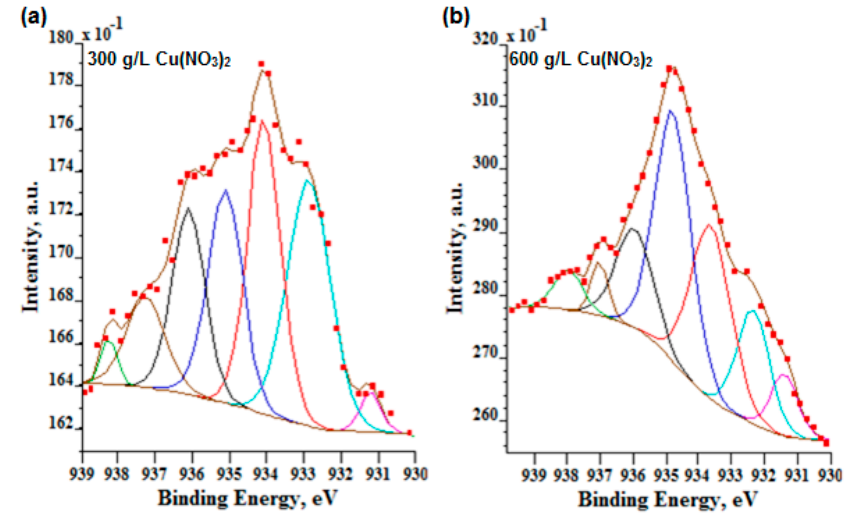
Figure 8. High XPS resolution Cu 2p 3/2 spectra within their fitting of the surface layer formed on titanium after PEO in the electrolyte containing 300 g/L ( a ) and 600 g/L ( b ) of Cu(NO 3 ) 2 in H 3 PO 4 . In Figure 8 and Table 5, the high resolution Cu 2p 3/2 spectra for two high signals (300 g and 600 g of Cu(NO 3 ) 2 per 1000 mL H 3 PO 4 ) are presented. The two first peaks at 932.3 eV and 932.9 eV (Figure 8a) and 932.4 eV (Figure 8b) and for both analyzed electrolytes can be interpreted most likely as CuP 2 and Cu 2 O, respectively. Other peaks of the ingrown energies are also responsible for the presence of Cu 2+ , i.e. , 933.6, 934.1 eV are responsible mostly for CuO; 934.8, 935.1, 936.1, 937.2, 938.1 eV peaks may be responsible for the presence of Cu 2+ , most likely as the CuO ∙ Cu 3 (PO 4 ) 2 ∙ nH 3 PO 4 compound in the PEO layer. Following that path, it should be noted that the more copper nitrate in electrolyte, the more anaerobic (CuP 2 ) and aerobic phosphorus-copper compounds (Cu 3 (PO 4 ) 2 ∙ nH 3 PO 4 ) are in the PEO surface layer. Table 5. Fitting results of Cu 2p 3/2 high resolution XPS spectra: BE—Binding Energy, FWHM—Full width at half maximum. 300 g/L Cu(NO 3 ) 2